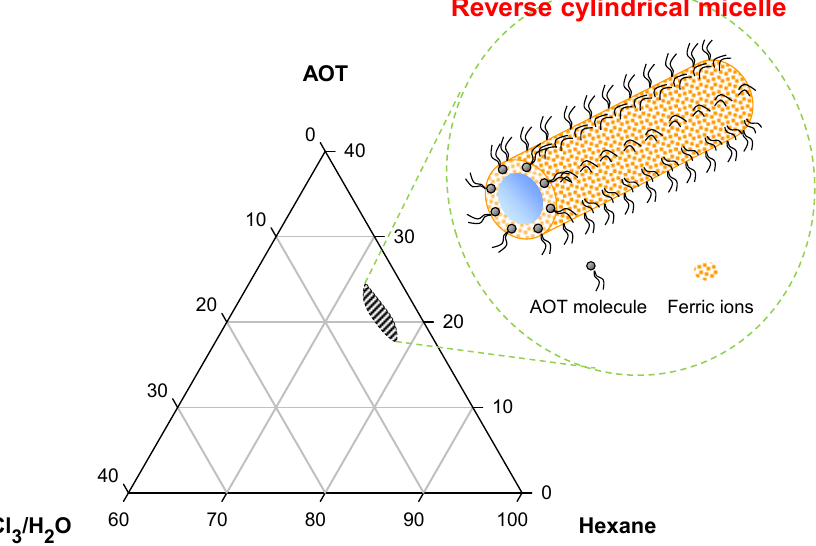
Figure 4. Partial ternary phase diagram for the hexane/AOT/aqueous FeCl system determined at 15 °C. The molar concentration of the aqueous FeCl 16.2 M. The marked area corresponds to the AOT reverse cylindrical micelle phase region. With permission from [22]; Copyright 2005, American Chemical